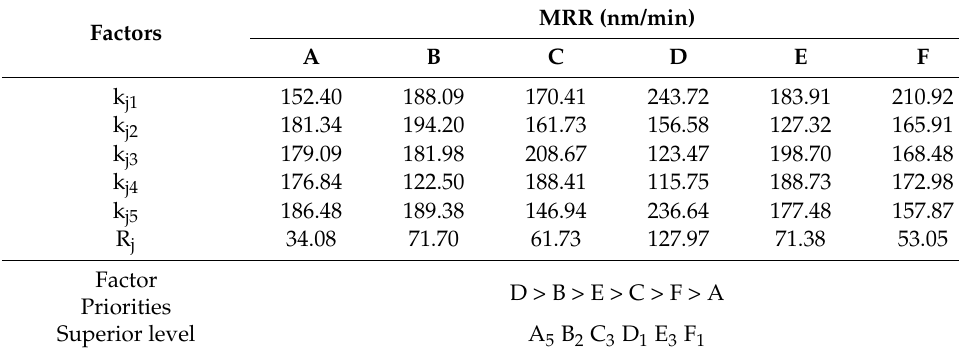
Table A3. MRR orthogonal data